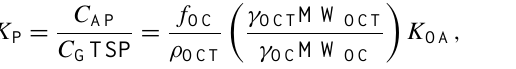
Figure 3. Aerosol–particle partitioning of PCBs and HCB. Log– log relationship between aerosol–gas partition coefficient ( K P ) and octanol–air partitioning coefficient ( K OA ) for PCBs and HCB. K OA values were corrected for